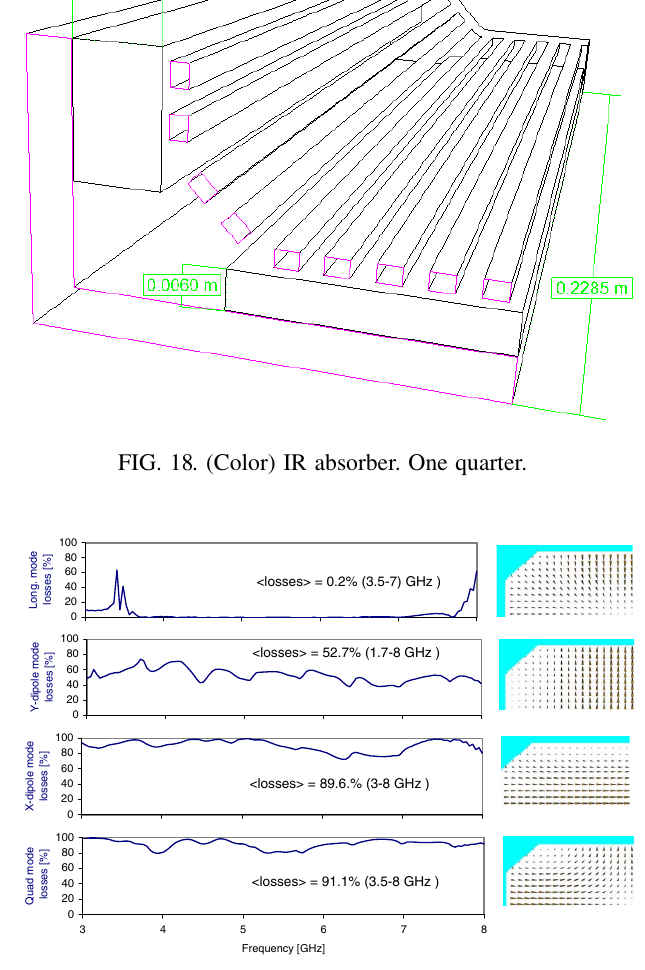
FIG. 19. (Color) Losses of different modes in the IR absorber.